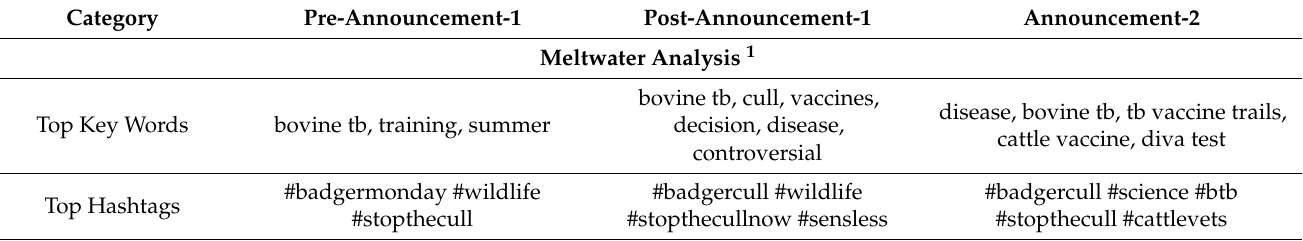
Table 3. Prominent features of discussion, authors and the prevailing